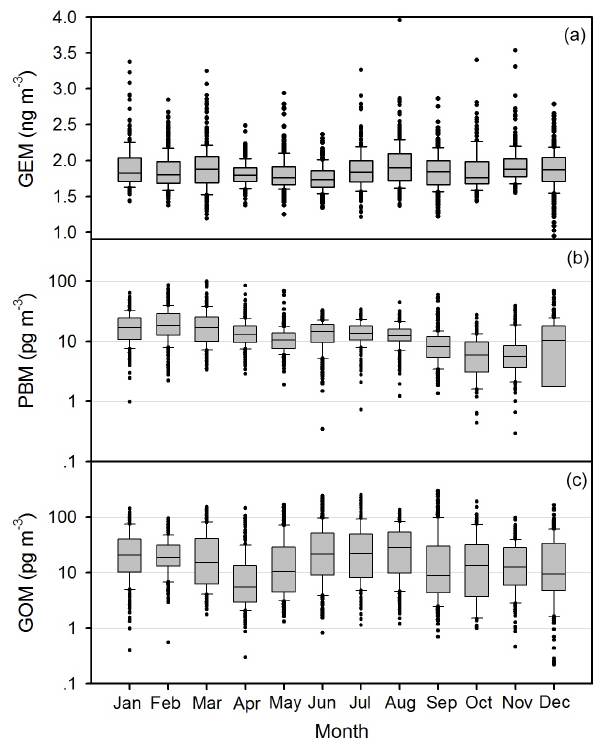
Figure 1. Monthly variation of atmospheric GEM (a) , PBM (b) , and GOM (c) at the PDM Observatory. Box lines indicate the 10th, 25th, 50th, 75th, 90th percentiles, and data points indicate concentrations below 10th and above 90th percentiles.